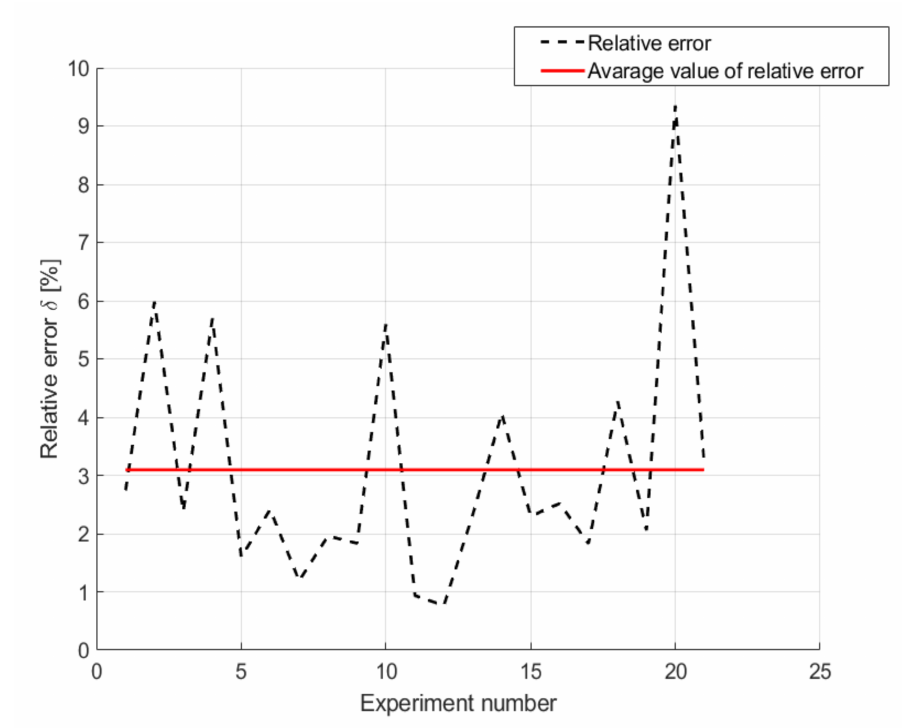
Figure 17. Relative